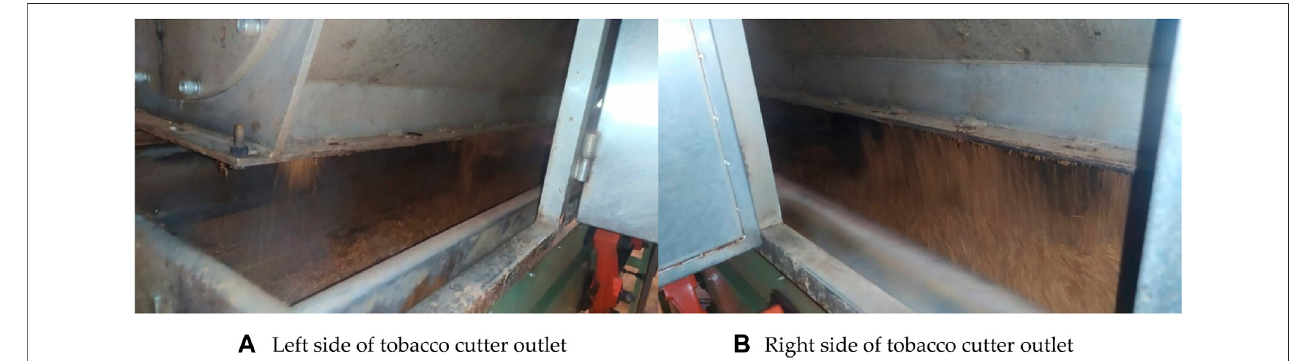
FIGURE 1 | Tobacco cutter